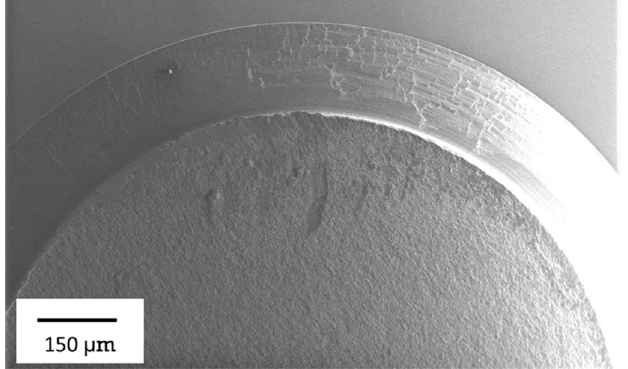
Figure 15. SEM-SE micrographs of multiple crack initiation sites in notched specimen. The outermost zone of the fracture surfaces of the specimen was partially damaged by the final stage of fracture.